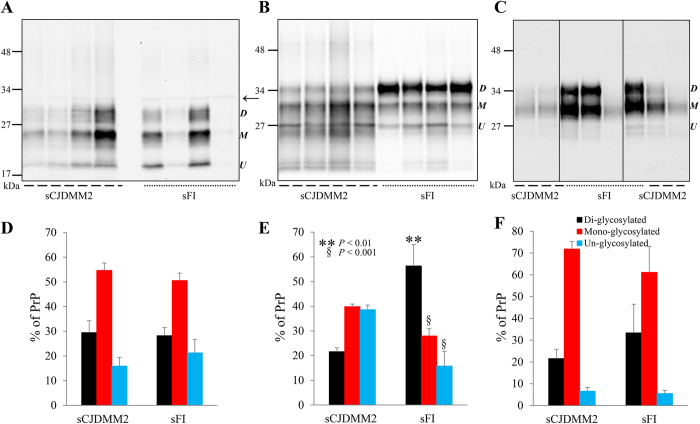
Western blot profiles and glycoform ratios of PK-treated and untreated PrPSc, as well as presumed PrPC, from sCJDMM2 and sFI.BH from sCJDMM2 and sFI were precipitated with NaPTA, and the totPrPSc-containing pellets were either PK-treated (PK 10 U/ml) generating resPrPSc (A) or left untreated (totPrPSc) (B). The percent distribution of the glycoforms of resPrPSc and totPrPSc harvested from NaPTA precipitates are shown in the bar graphs (D,E). (A,B,D,E) Unlike resPrPSc, totPrPSc shows WB profiles that differ in the two diseases because of a significant over-representation of the di-glycosylated form in sFI. In (A), a non-specific band of ~32 kDa is also observed (arrow). Following NaPTA precipitation, the supernatants were precipitated in methanol and resuspended in sample buffer. (C,F) Supernatants from sCJDMM2 and sFI, run on the same gel but not in adjacent lanes, show similar ~27–37 kDa WB profiles and percent distribution of the glycoforms of “PrPC” (P > 0.05, Student’s t-test). In sFI, the “PrPC” glycoform ratio is significantly different from that of totPrPSc (B,E), indicating that the totPrPSc ratio is not due to contamination with “PrPC”. (Labels on the right side of each WB indicate the three PrP glycoforms: D: Di-glycosylated; M: Mono-glycosylated; U: Un-glycosylated. Tissue samples from four cases of sCJDMM2 and sFI, respectively, and the mAb to PrP, 3F4, have been used in all figures, unless otherwise indicated).